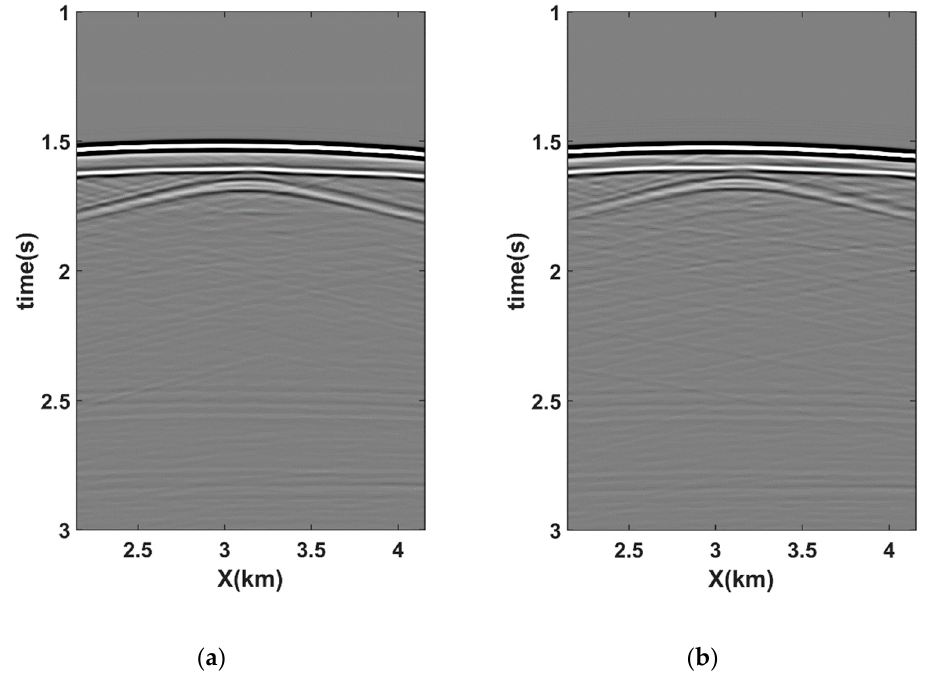
Figure 8. The common source gathers with a row of virtual receivers x vr = (X: 2155–4145 m, Z: 5555 m) corresponding to the surface source at 3150 m in X-coordinate from ( a ) the standard Marchenko receiver redatuming method retrieved wavefield and ( b ) the wavefield obtained by waveform modeling. Second, we use the VSP Marchenko source-receiver redatuming to retrieve the Green’s ( x vsp ) and its corresponding wavefield. The virtual receiver locations function G mar vr , x vsp all